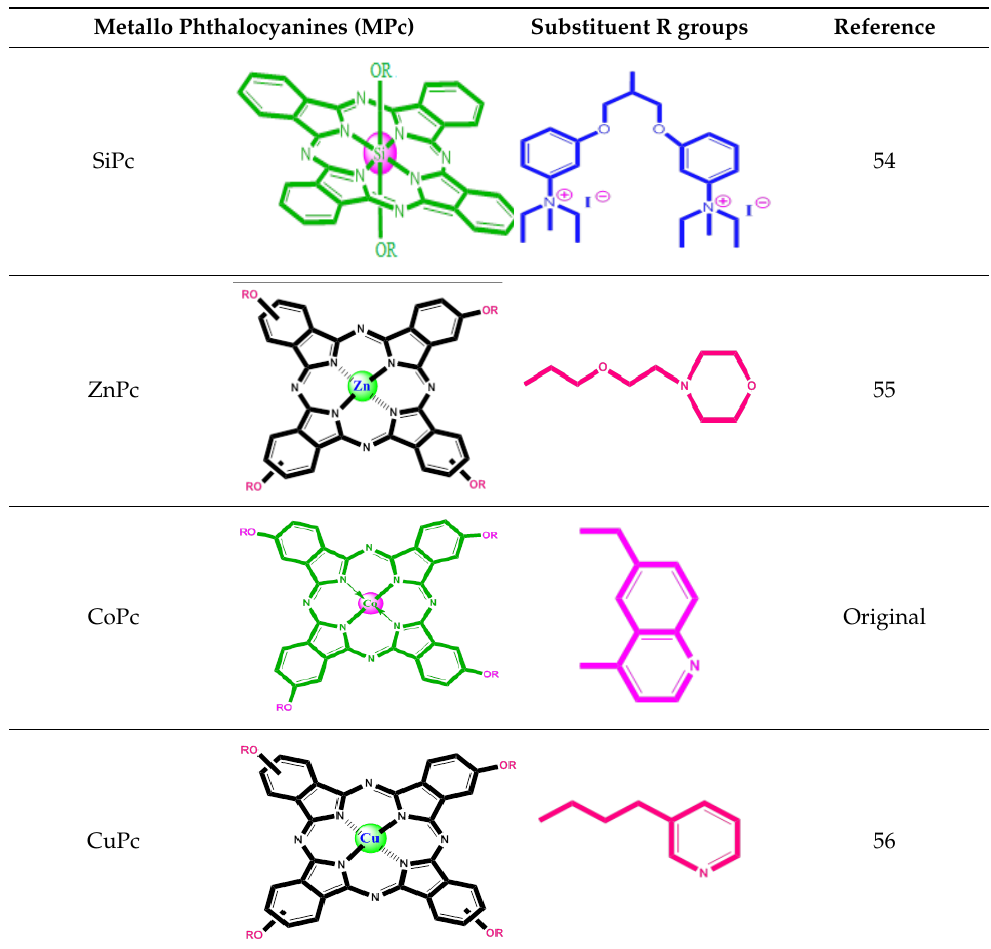
Table 1. Pc molecules used in sensitization of TiO 2 .